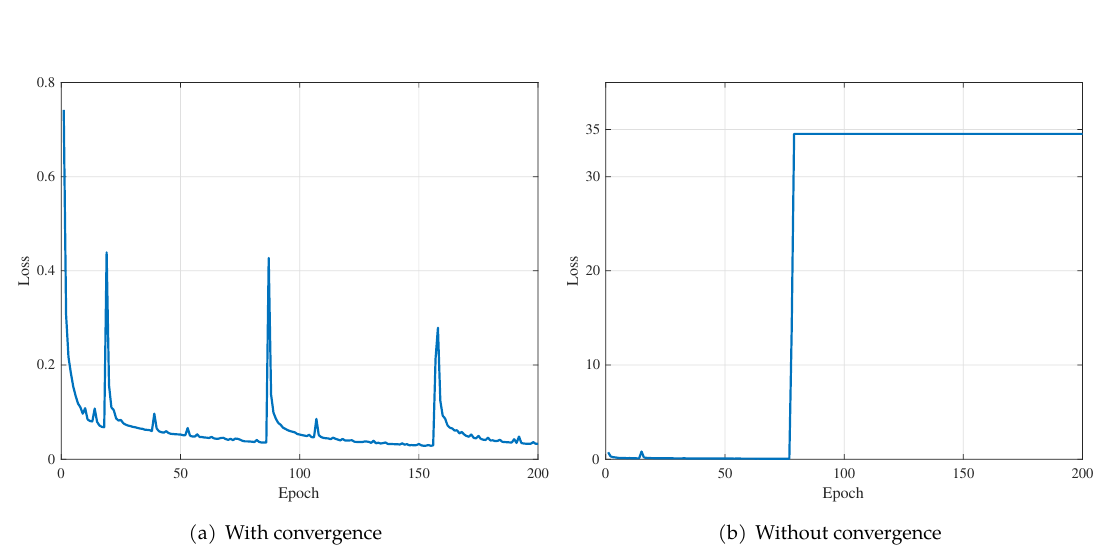
Figure 1: The loss curve during training of the traditional GraphSAINT Table 2: Results for the improved GraphSAINTs on the citation dataset of OGB GraphSAINT Training Validation Test LN